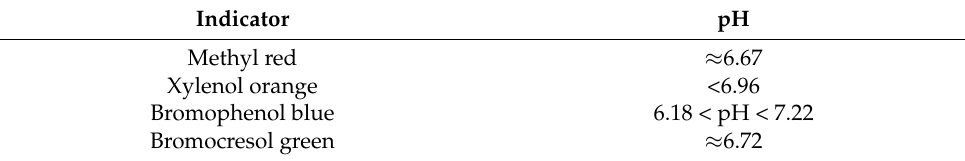
Table 10. Results of the pH values of the buffer solution using the indicators.